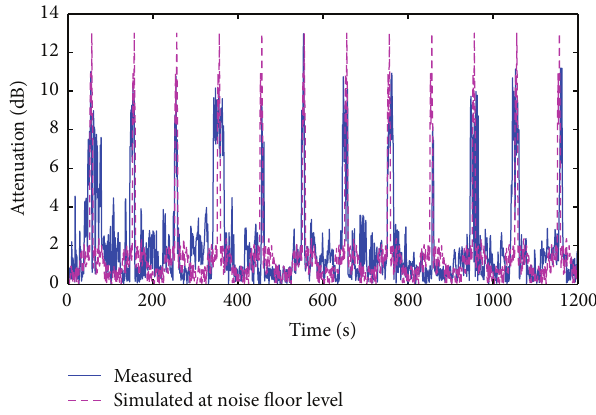
Figure 19: Measurement of attenuation inasmuch (PAs) + simula- tion at noise floor level, time series.